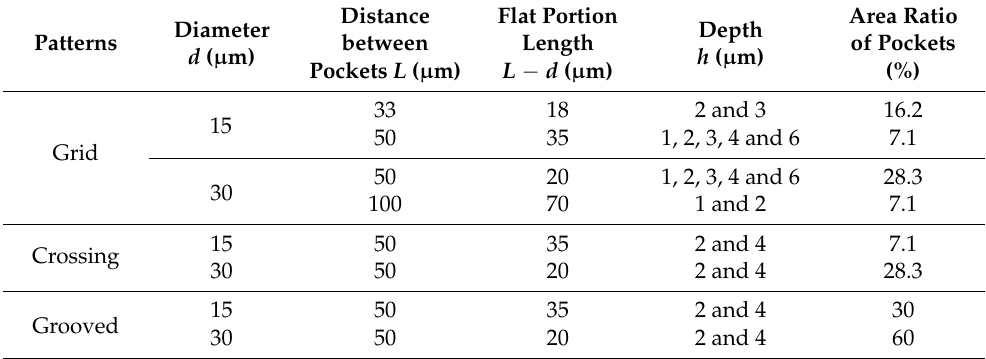
Table 1. Geometrical parameters of array pa tt erns of micro-pockets.